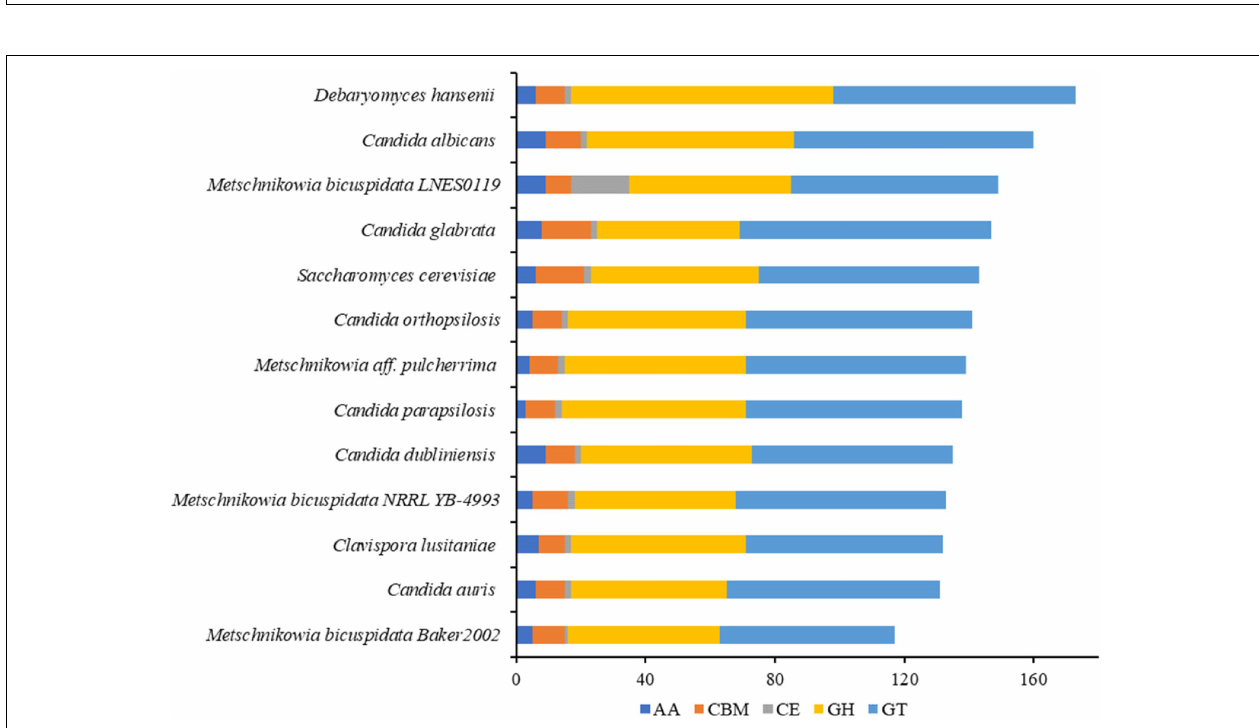
FIGURE 3 | Number of CAZymes genes in M. bicuspidata LNES0119 and the other 12 yeasts. GH: glycoside hydrolase, GT, glycosyltransferase; CE, carbohydrate esterase; AA, auxiliary activity; CBM, carbohydrate-binding module.